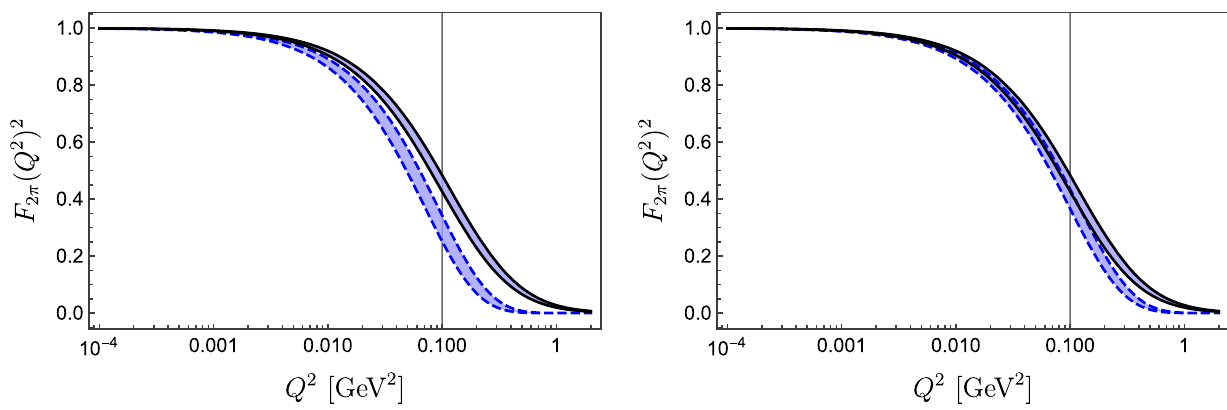
Fig. 2 The square of the eff Eq. (44). Full lines represent lattice data [65] and the band stands for the error in the mean distance entering the lattice pasteurization, see Eq. (46). Left panel the same observable for the GSWL2. Right panel the same for the GSWL1